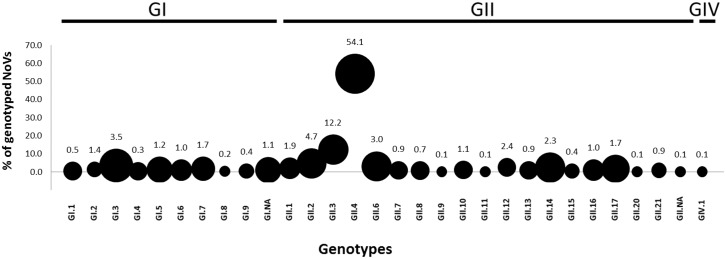
Prevalence of various NoV GI, GII and GIV capsid-based genotypes detected in children with gastroenteritis in 18 African countries between 1976–1979 and 1997–2013.A total of 940 NoV strains were genotyped, the percentage of each genotype out of the total typed strains is indicated above each circle. The size of the circle represents the geographical distribution of a given genotype. The smallest circle represents 1/18 countries and the largest circle represents 14/18 countries.